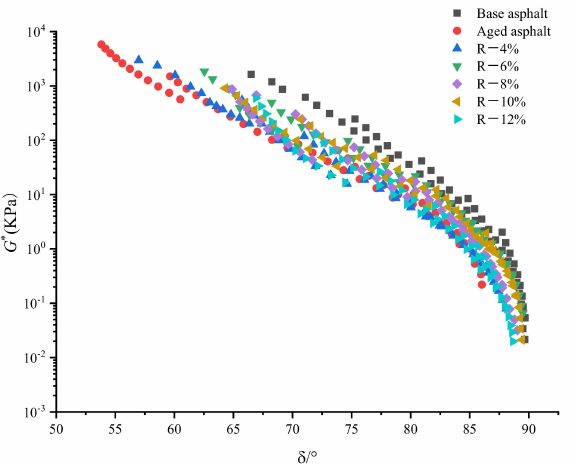
Figure 6. Black diagram of reclaimed asphalt.